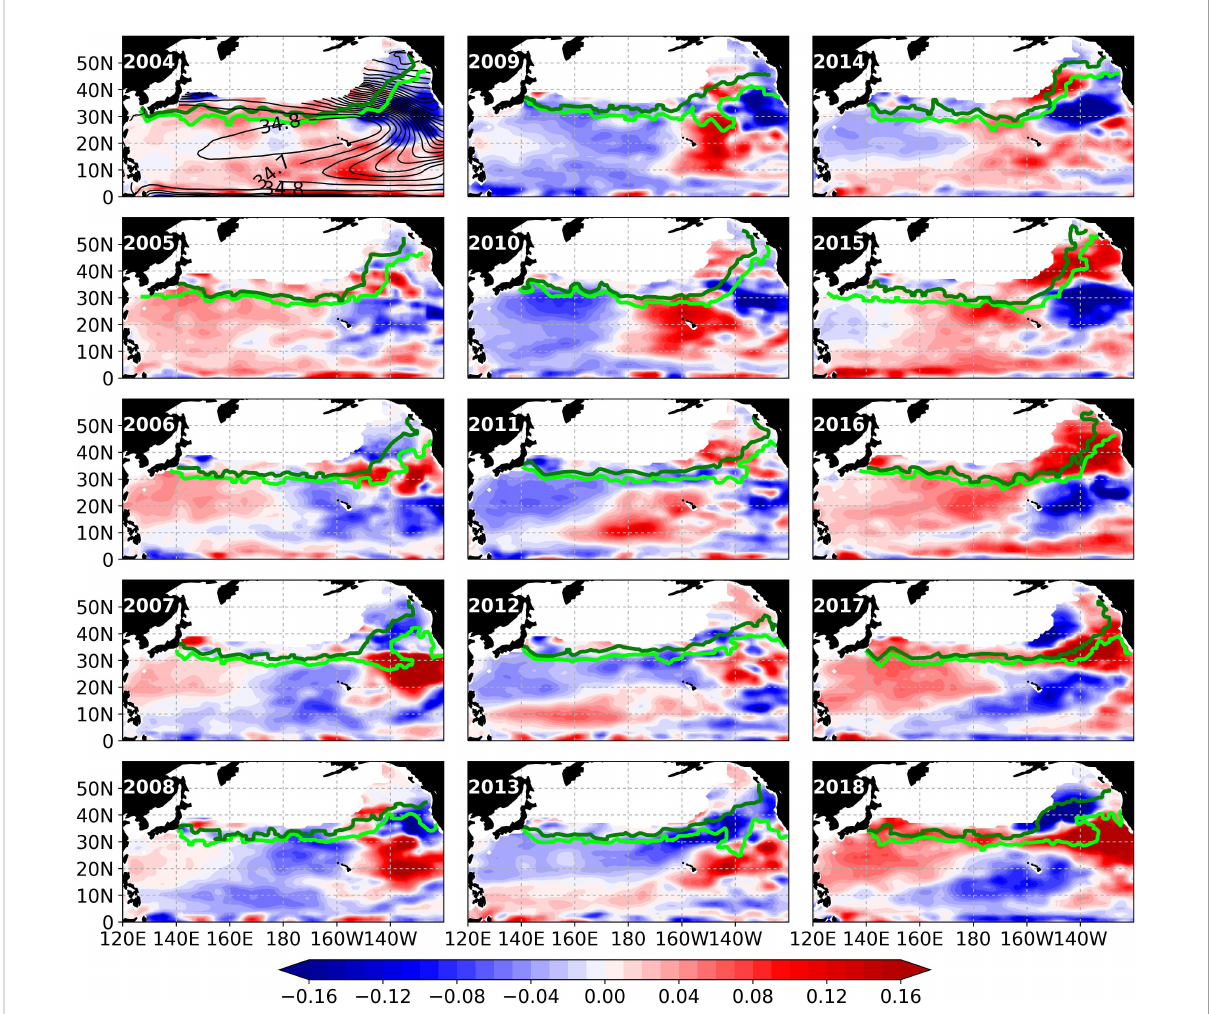
FIGURE 8 Annual mean anomalies of salinity averaged between 25.0 and 25.3 g surfaces. Climatological salinity (black contours) is shown in the subplot of 2004 with intervals of 0.1 and labels of 34.7 and 34.8. Light green and dark green lines denote the late winter outcrop line for g 25.0 and g 25.3 respectively, which was averaged in February and March of each